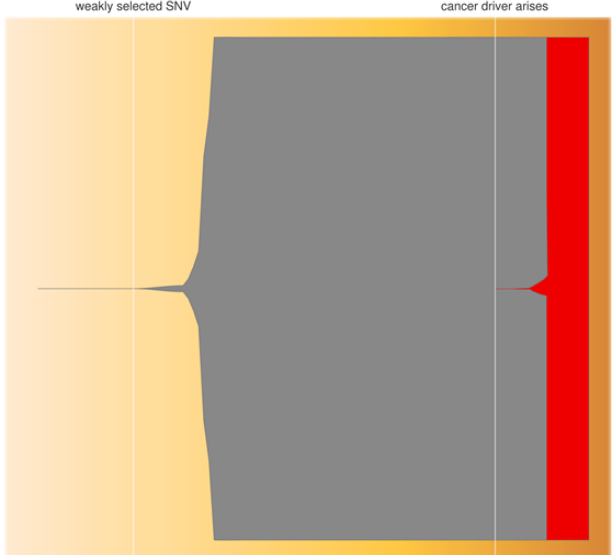
Figure 4. Clonal expansion of first a weakly selected Single-Nucleotide Variant (SNV) arising at generation two of iPSC in vitro culture (grey), followed by a second cancer driver mutation at generation 60 (red). The height of the expanding clones indicates allele frequency in the population. The weakly selected SNV reaches a frequency of 100%, replacing all cells bearing the donor-cell allele, but is then itself replaced by the more highly selected cancer driver which reaches 100% by generation 70. Plot produced using R package fish plot (version 0.5 [174]), with timings of mutations and rates of clonal expansion estimated using the parameters and equations in Section 4.2